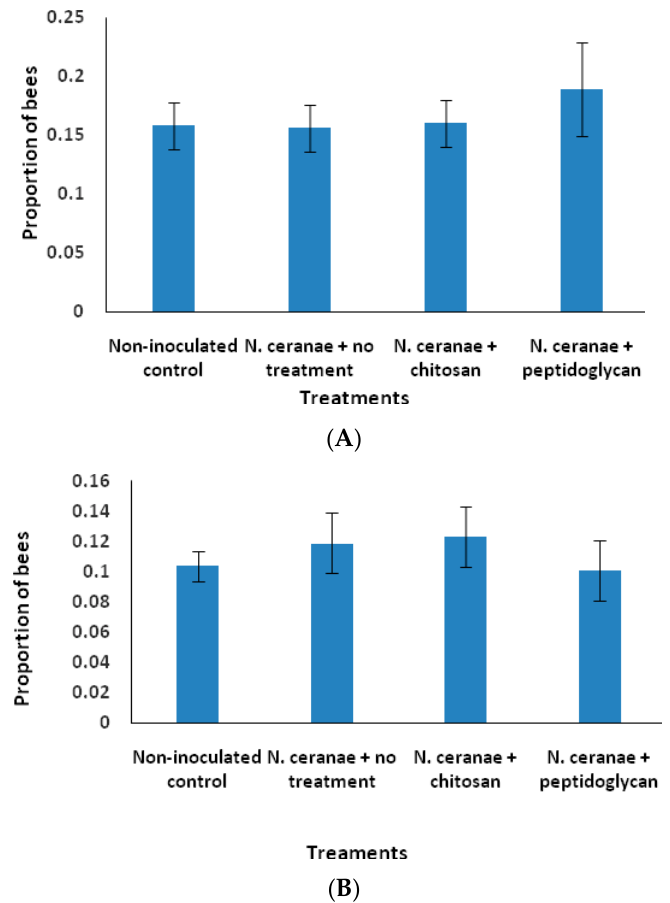
Figure 2. ( A ) Proportion (± SE) of worker honey bees that uncapped cells from a comb section containing freeze-killed brood. ( B ) Proportion (± SE) of worker honey bees that removed dead pupae from a comb section containing freeze-killed brood. Bees were inoculated with 1 × 10 5 spores of N. ceranae only ( N. ceranae + no treatment), inoculated with N. ceranae and 1.0 µg/µL of chitosan ( N. ceranae + chitosan), N. ceranae and 1.0 µg/µL of peptidoglycan ( N. ceranae + peptidoglycan) or not inoculated or treated (Non-inoculated control) (n = 500 per treatment).